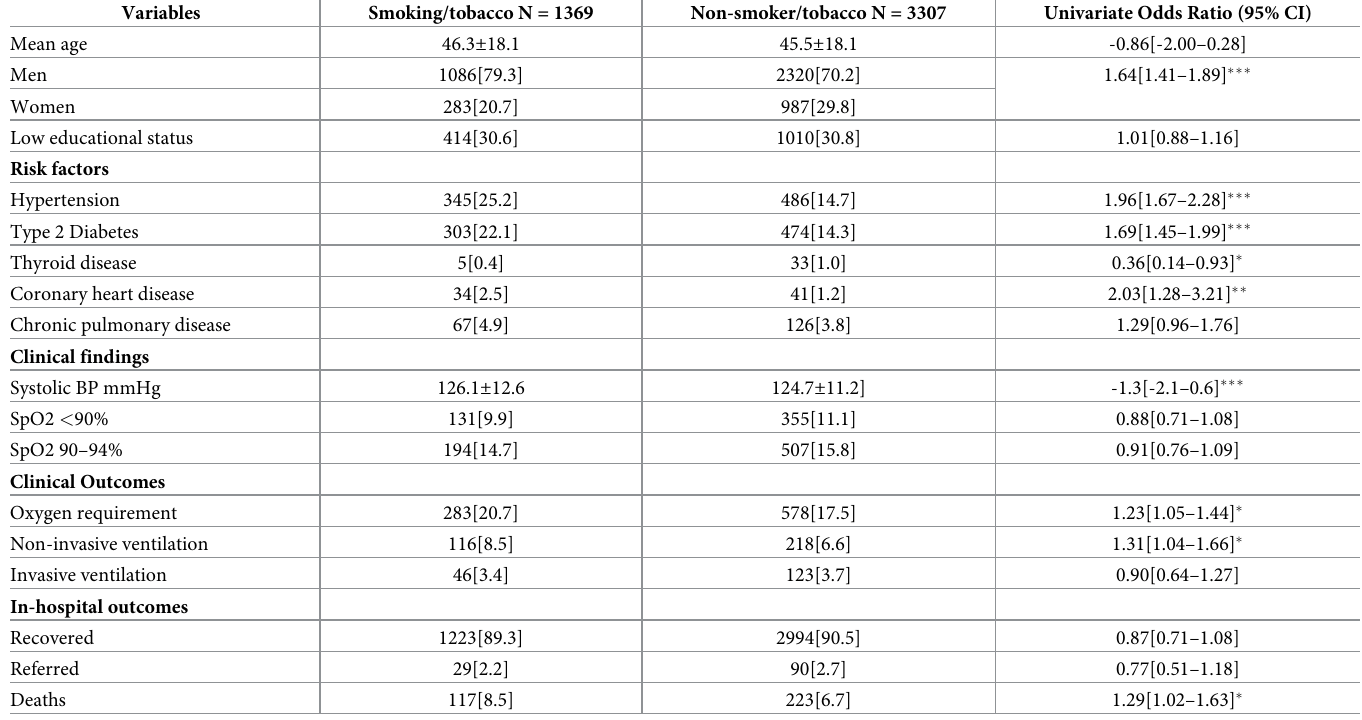
Table 5. Clinical characteristics and outcomes according to smoking/tobacco use.